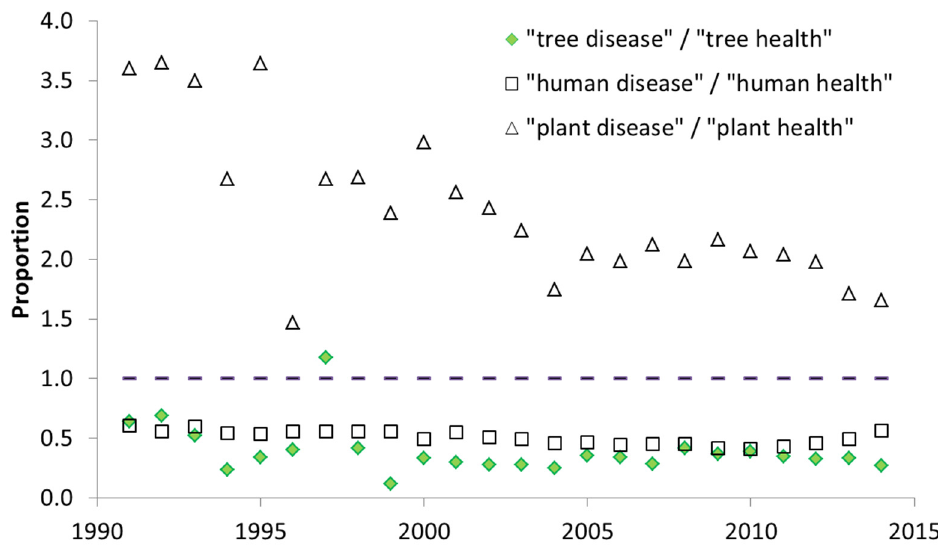
Figure 3. Number of publications retrieved in Google Scholar (1991–2014, as of September 2015) searching for the keyword “tree disease” relative to the number of publications retrieved using the keyword “tree health”, and for human/plant disease in comparison with human/plant health, respectively. Modified from [86].